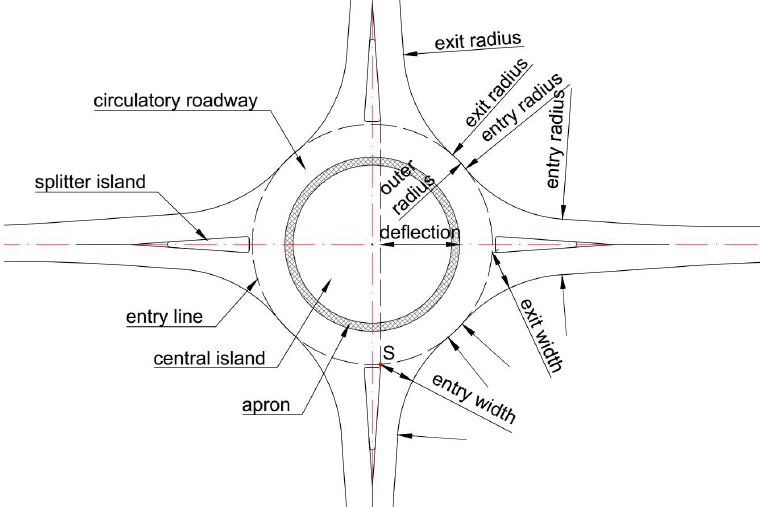
Figure 1. The geometric elements of single-lane roundabouts.